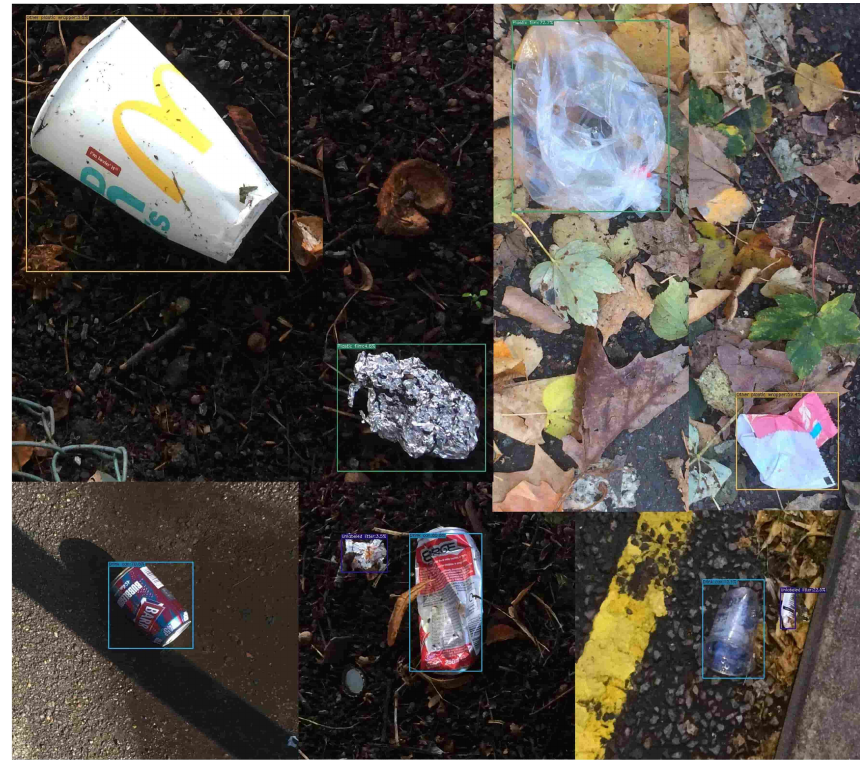
Figure 12. Visualization results of YOLOX-S 1 on the TACO dataset.